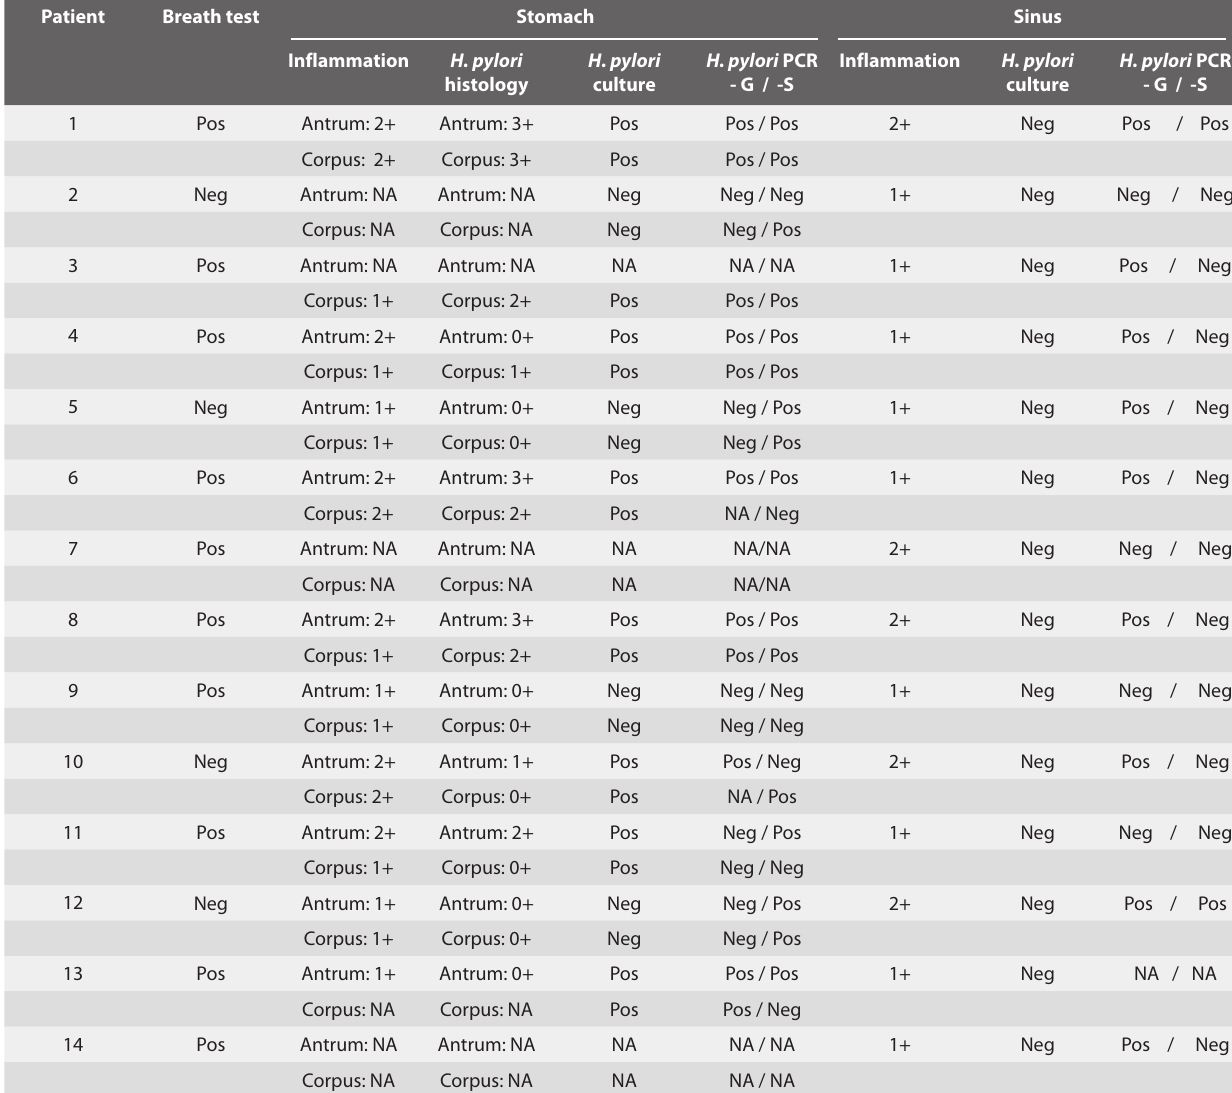
Table 1. Status of gastric and nasal inflammation and H. pylori infection for all